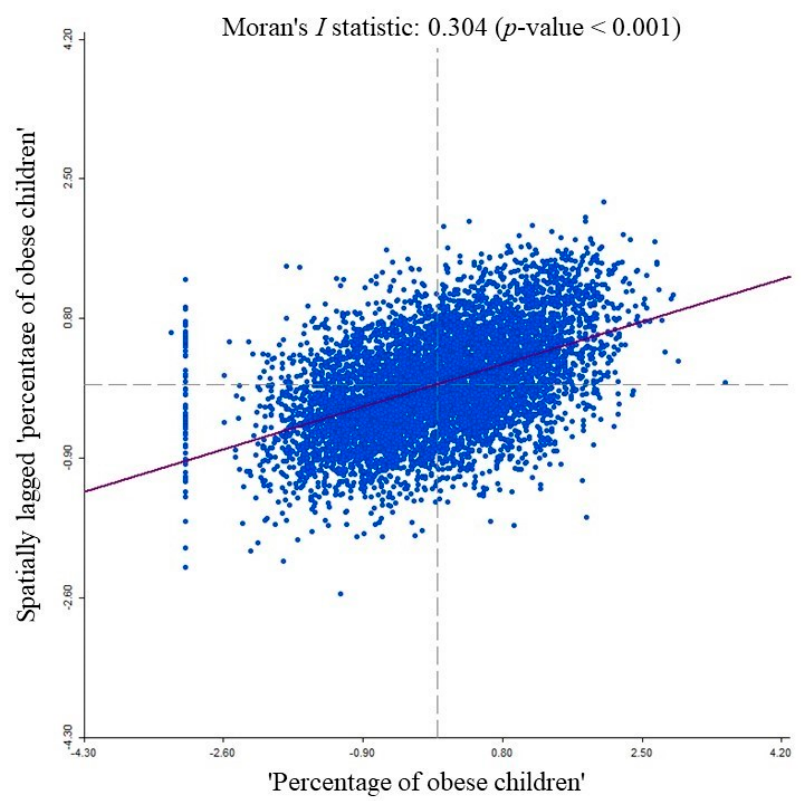
Figure 3. Global Moran scatterplot of MSOA ‐ level “percentage of obese children”.